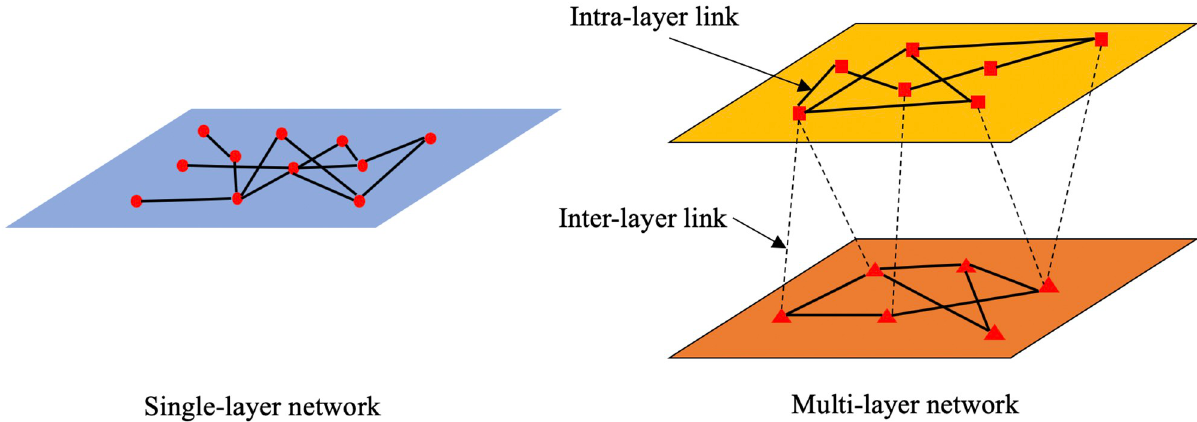
Fig 1. Single-layer network and multi-layer